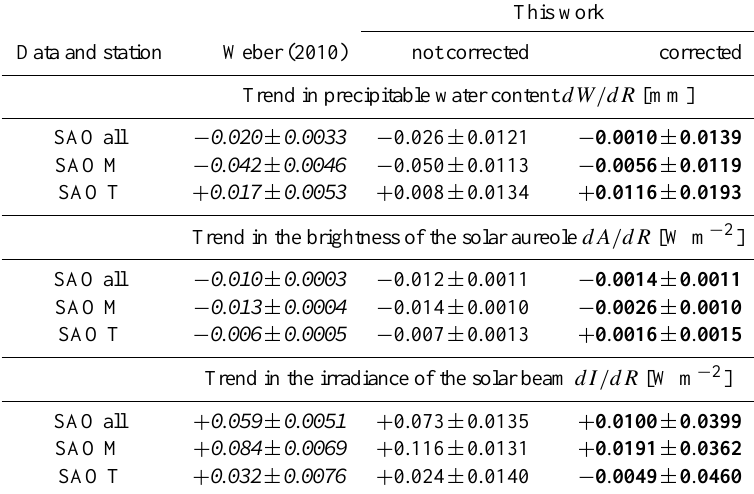
Table 1. Dependence of precipitable water content W , aureole brightness A and the irradiance I of the direct solar beam on sunspot number R as measured by the best-fitting linear slopes dW/dR , dA/dR , and dI/dR for the SAO data taken at Cerro Montezuma (M) and Table Mountain (T). The second column lists the values as reported in Table 1 of W10, but with 1 σ error bars. In the third column the values from this re-analysis of the data are presented, showing mostly very similar values to the ones in W10, but substantially larger 1 σ error bars. Finally, the values in the last column are based on data corrected for seasonal variations and without periods affected by volcanic aerosols or local pollution. After correcting for these effects and with improved error estimates from bootstrapping simulations, the data show no significant trend of the three quantities with sunspot number. This work Data and station Weber